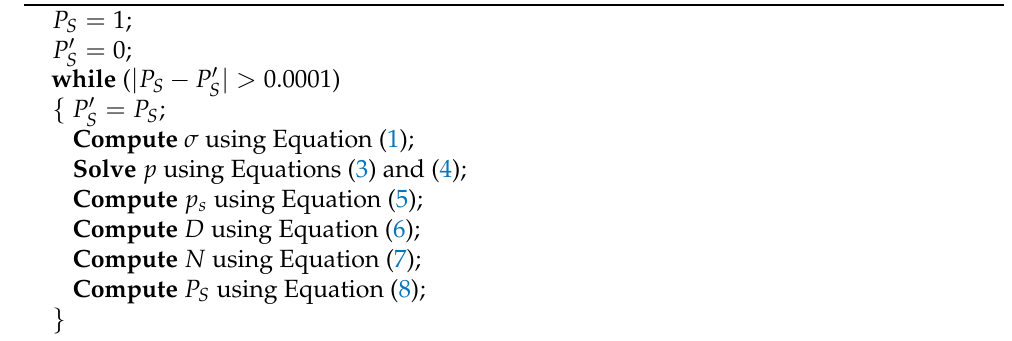
Algorithm 1: Algorithm for computing P S , D , and N .